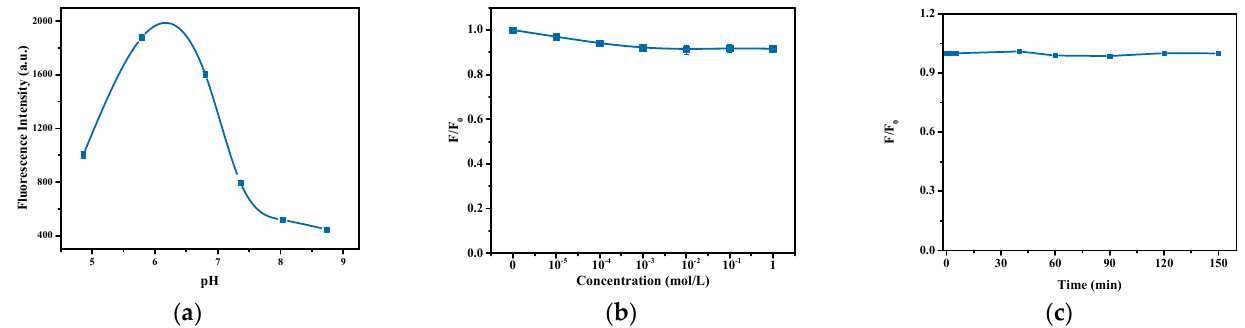
Figure 6. Effect of pH ( a ), ionic strength ( b ), and exposure time under UV light ( c ) on the fluorescence stability of FHF 470.